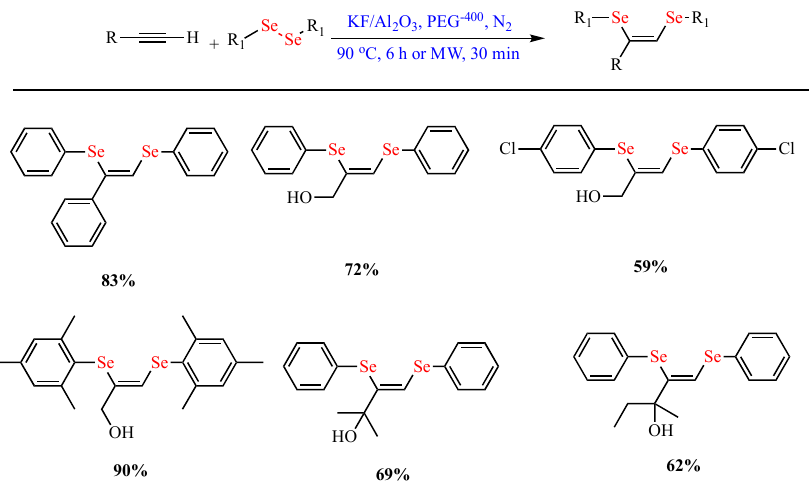
Scheme 7. Synthesis of 3-((arylethynyl)selanyl)-1 H -indoles.